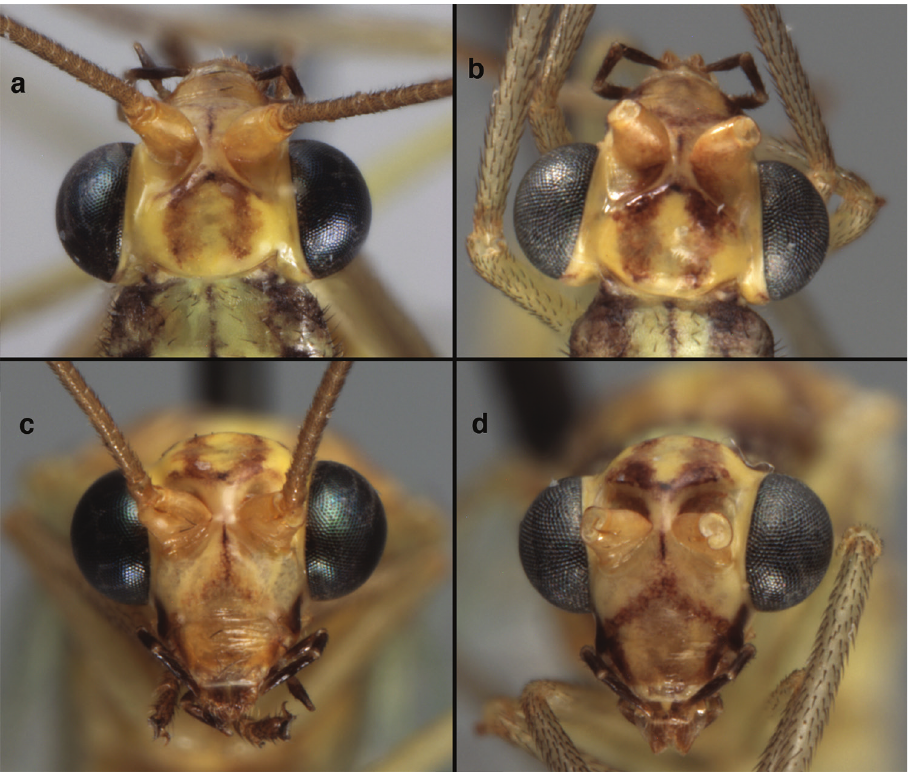
Figure 115. Ungla chacranella (Banks): Variation in head markings, ( a, b ) head, dorsal ( c, d ) head, frontal (Argentina, La Rioja, male,